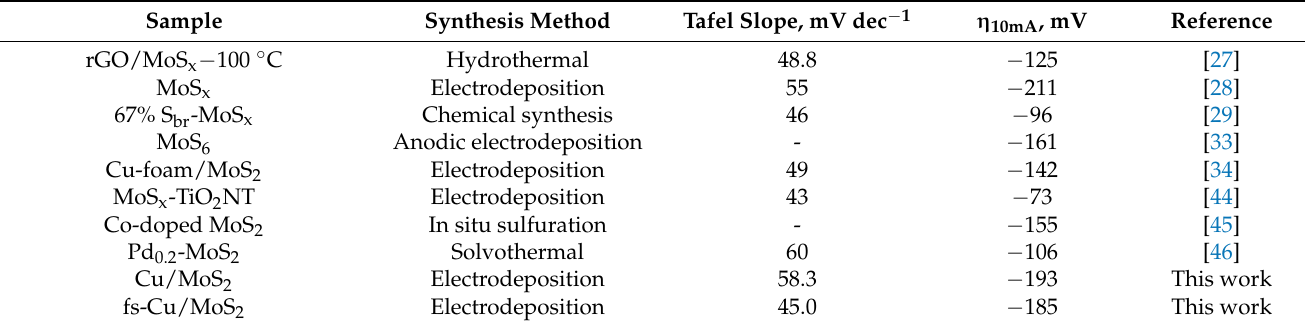
Table 3. The comparison of the reported Tafel slopes and overpotentials at the 10 mA cm − 2 HER